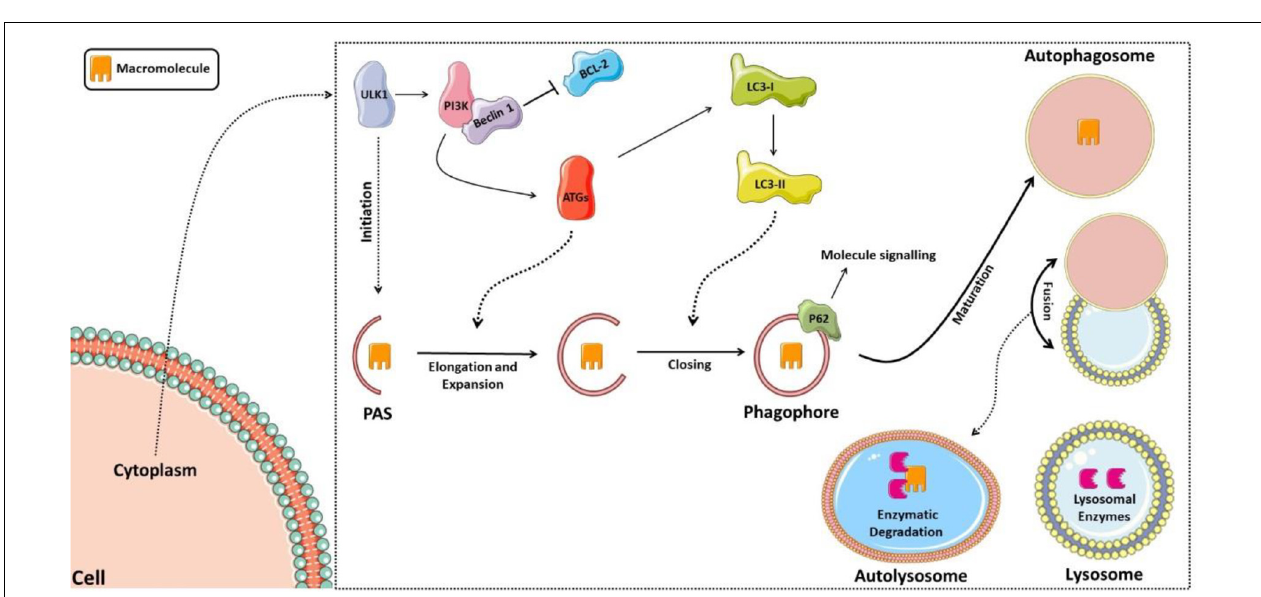
FIGURE 1 | Representative diagram of the interaction between anorectic hormones, molecular pathways, and neuropeptides POMC and AgRP. Anorexigenic hormones (leptin and insulin) act on the hypothalamic arcuate nucleus, reducing AMPK activation in AgRP neurons, thus reducing its expression. In POMC neurons, hormones increase mTOR activity and reduce AMPK, increasing its expression and reducing food intake and eutrophic phenotype.